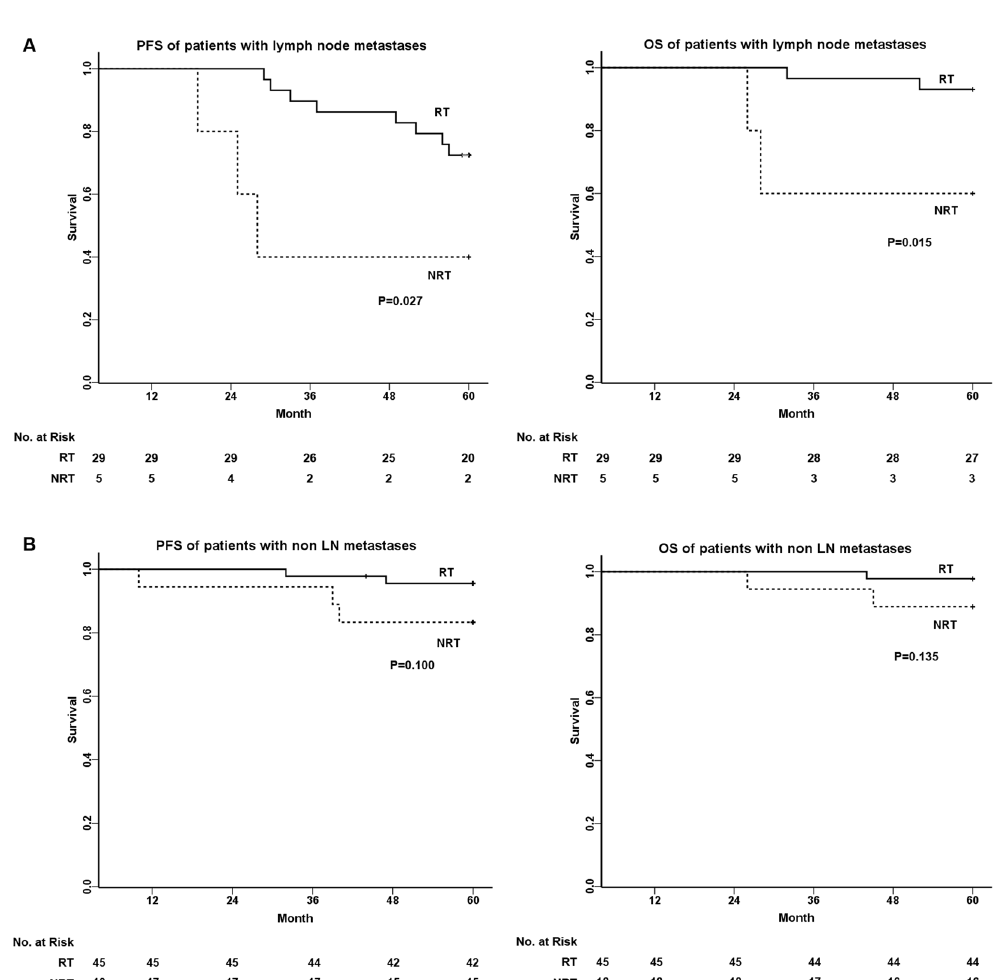
Figure 2. Survival analysis of young patients with SCC related to LN metastases between two study groups: NRT and RT. (A) For patients with LN metastases, the five-year PFS in NRT and RT groups were 40.0% vs. 72.4% (P = 0.027), and the five-year OS in NRT and RT groups were 60.0% vs. 93.1% (P = 0.015). (B) For patients with non-LN metastases, the five-year PFS in NRT and RT groups were 83.3% vs. 95.5% (P = 0.100), and the five-year OS in NRT and RT groups were 88.9% vs. 97.8% (P =